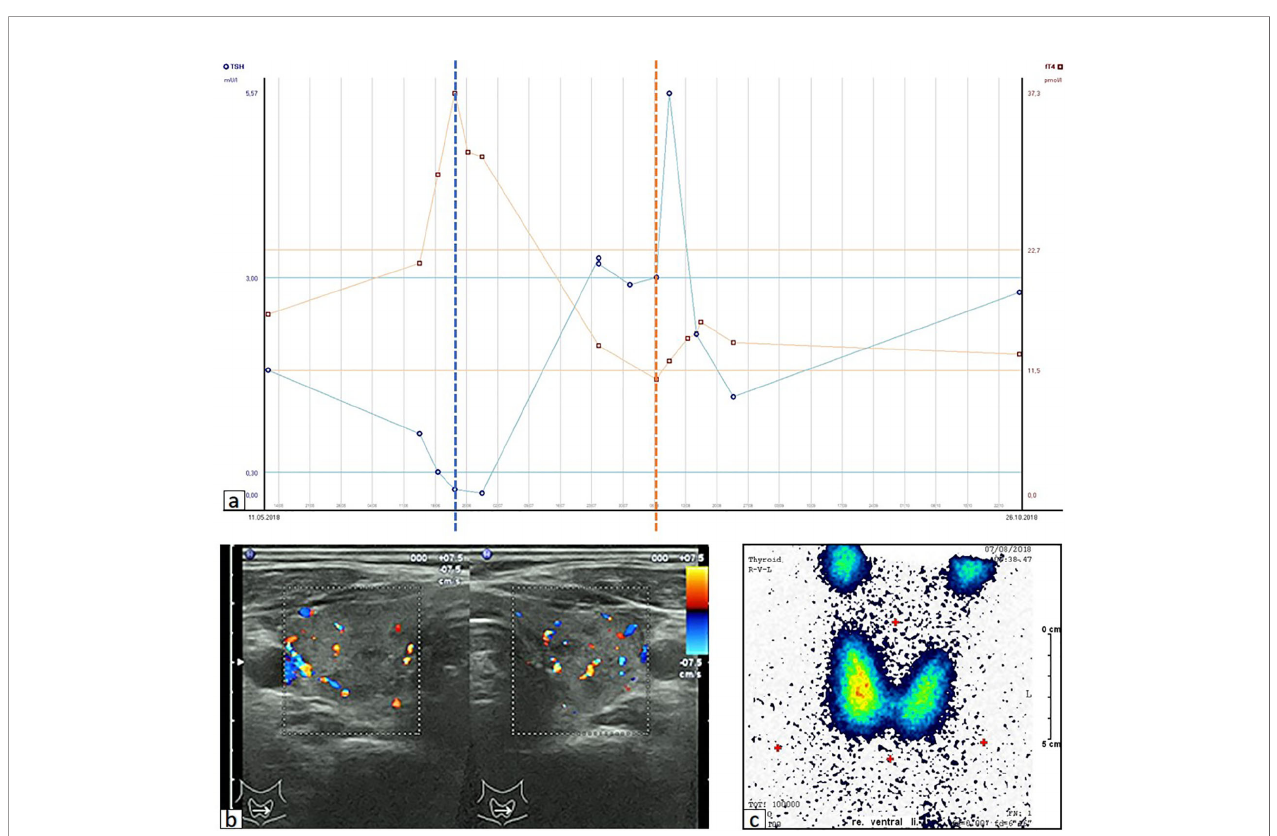
corresponding to autoimmune thyroiditis; Figures 3B, C . The patient was started on thyrostatic therapy with thiamazole 40 mg/d leading to euthyroidism after 8 weeks. Corticosteroids were tapered slowly and the patient was discharged after 5 weeks of hospitalization in a good general condition. Another four weeks